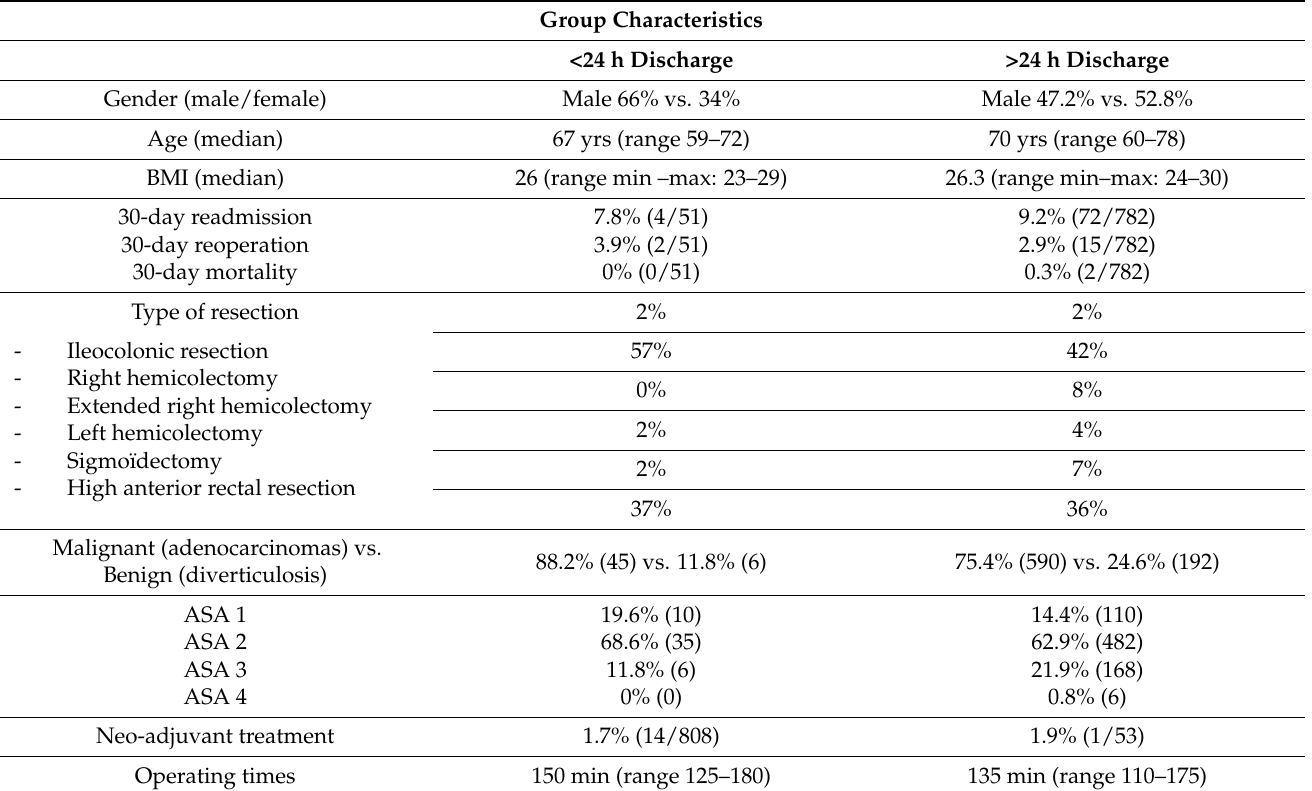
Table 2. Characteristics of patients according to group (<24 h discharge or >24 h discharge).